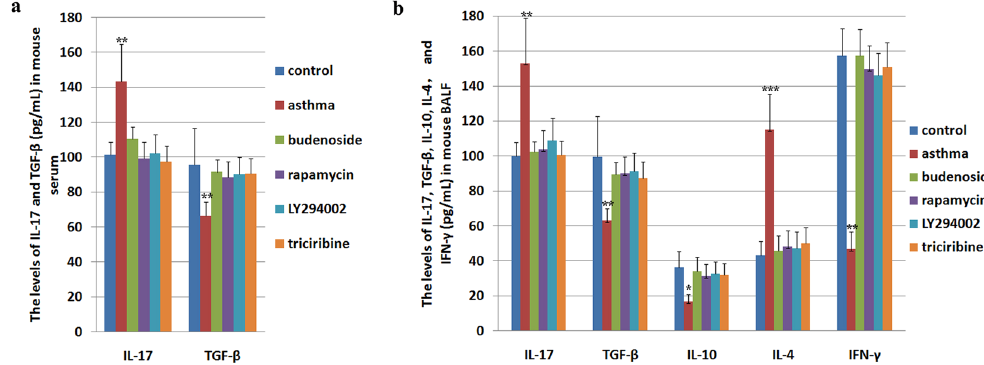
Figure 6. Levels of asthma-related cytokines in mouse serum and bronchoalveolar lavage fluid (BALF) determined by ELISA. ( a ) The levels of IL-17 (pg/mL) and TGF- β (pg/mL) in sera from mice in the control group and the OVA-induced asthma group, and the OVA-induced asthmatic mice treated with budenoside, rapamycin, LY294002, or triciribine. The asthmatic mice demonstrated significantly higher levels of IL-17 and lower level of TGF- β than in the control, budenoside treatment, and m-TOR pathway inhibitor treatment groups. No statistical significance was observed among those groups. ( b ) The levels of IL-17 (pg/mL), TGF- β (pg/mL), IL-10 (pg/mL), IL-4 (pg/mL), and IFN- γ (pg/mL) in BALF from mice in the control group and the OVA-induced asthma group, and the OVA-induced asthmatic mice treated with budenoside, rapamycin, LY294002, or triciribine. The asthmatic mice demonstrated significantly higher levels of IL-17 and IL-4, and lower level of TGF- β , IL-10 and IFN- γ than in the control, budenoside treatment, and m-TOR pathway inhibitor treatment groups. No statistical significance was observed among those groups. All data was presented as the mean ± SD. * p < 0.05, ** p < 0.01, *** p <